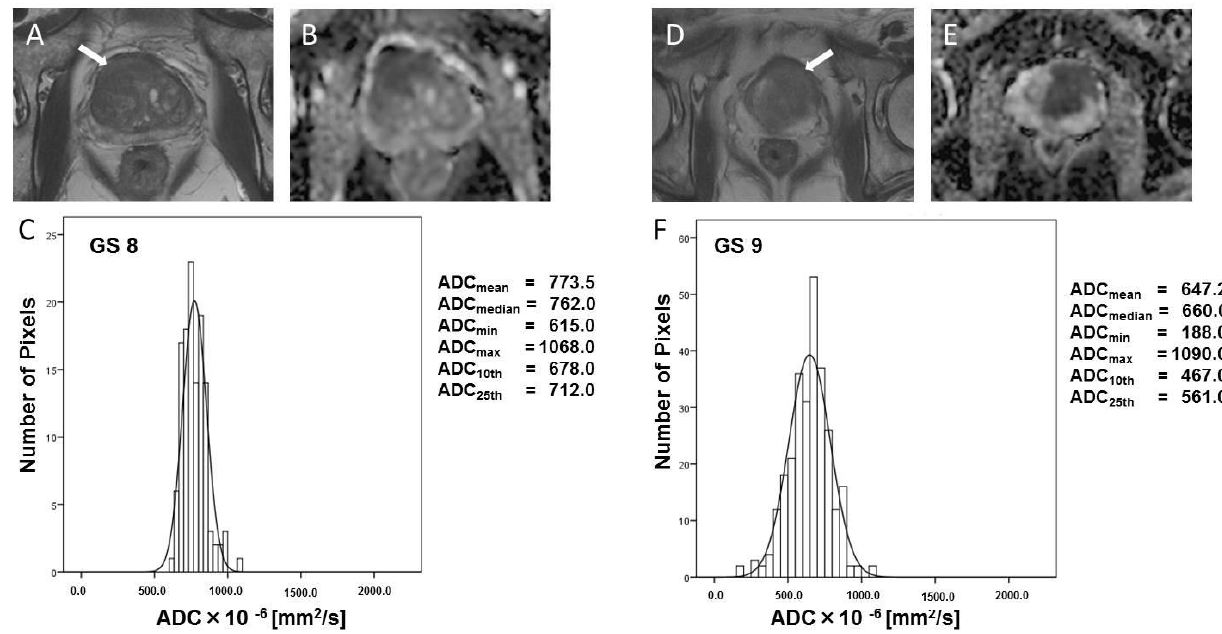
Figure 4. Typical histogram of tumor focus, and T 2 W and ADC images (GS 8 and GS 9). GS = Gleason score. Typical T 2 W images ( A , D ), ADC images ( B , E ), and ADC-derived histogram ( C , F ) for GS 8 and GS 9 prostate cancers. These T 2 W images of prostate cancer illustrate the low signal intensity. The ADC values of the GS 8 (( B ), ADC mean = 773.5 × 10 −6 mm 2 /s) and GS 9 (( D ), ADC mean = 647.2 × 10 −6 mm 2 /s) lesions reflect restricted diffusion on the ADC map. White arrows indicated tumor foci.